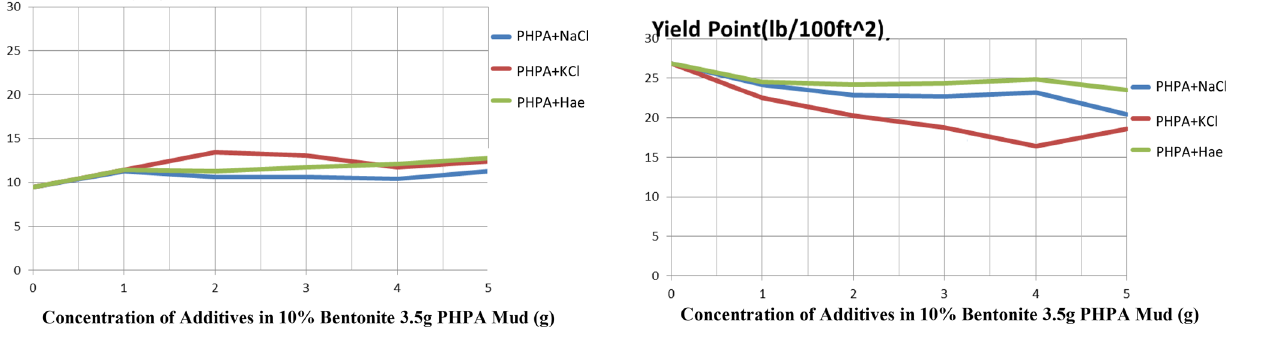
Fig. 16 Effect of NaCl, KCl and haematite on yield point of PHPA– bentonite mud